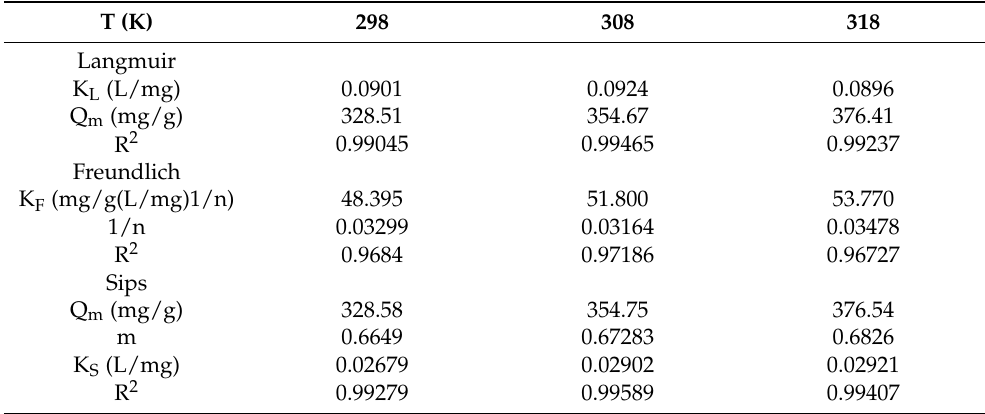
Table 3. Thermodynamic parameters of the biochar.